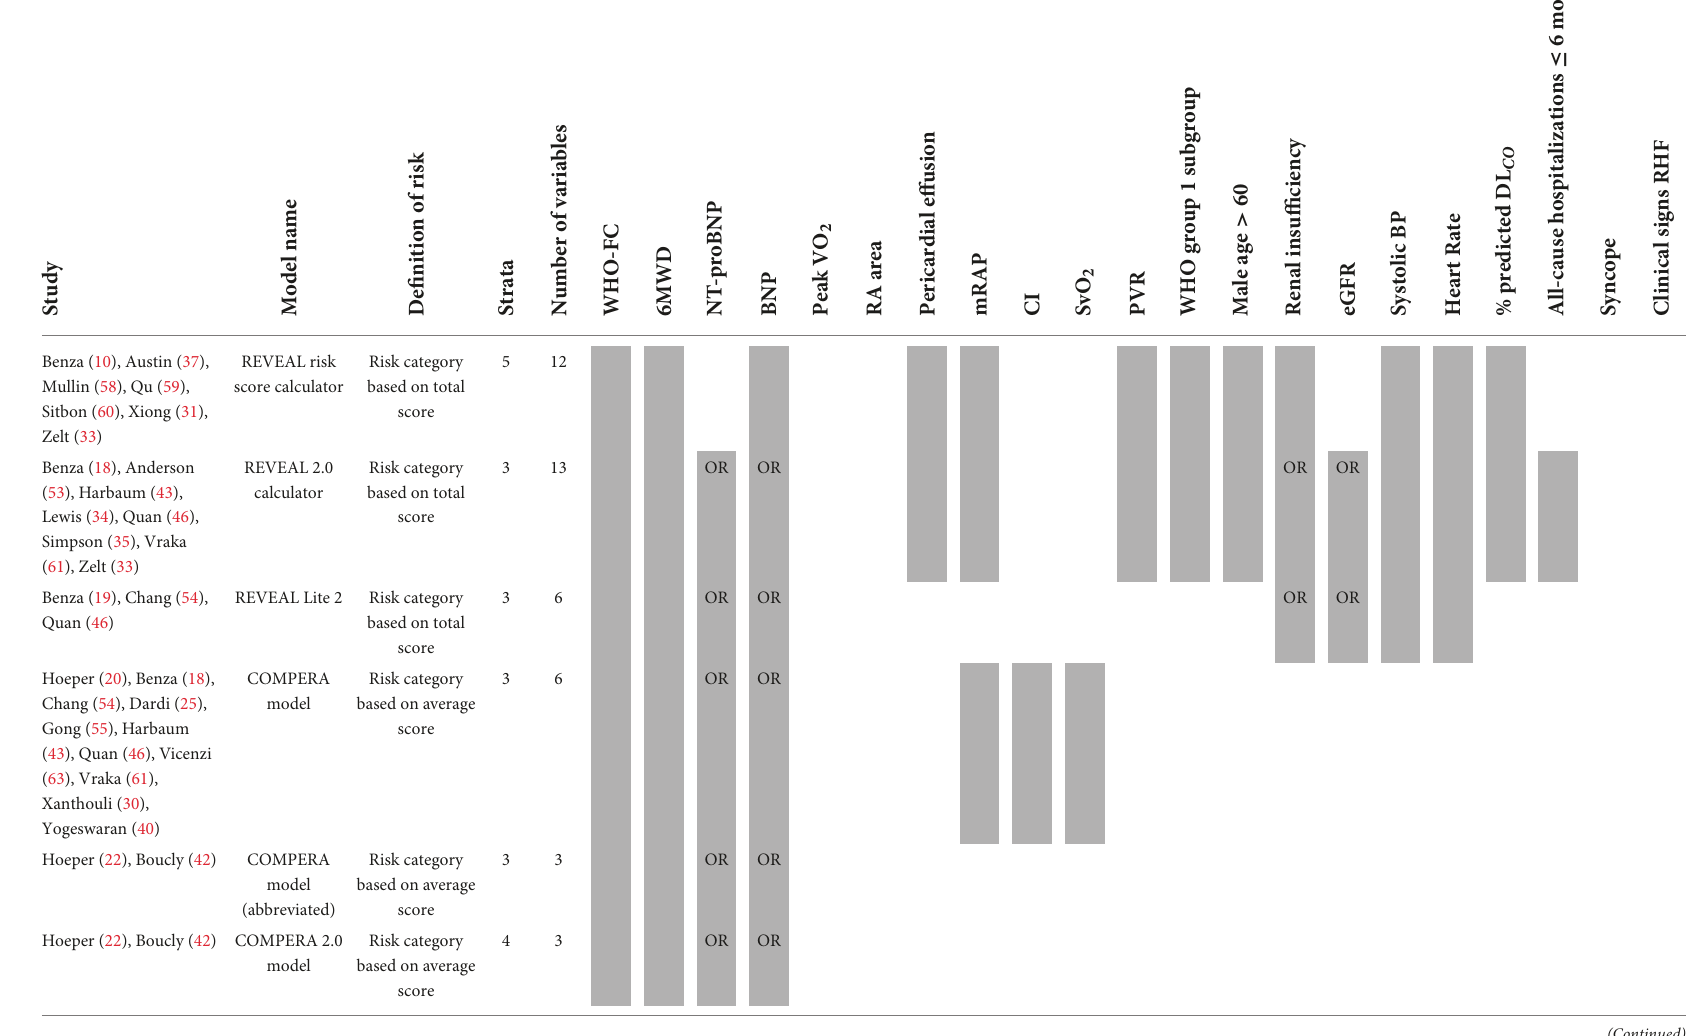
TABLE 4 Variables used in REVEAL and ESC/ERS 2015 guideline-based risk stratification models: development and validation